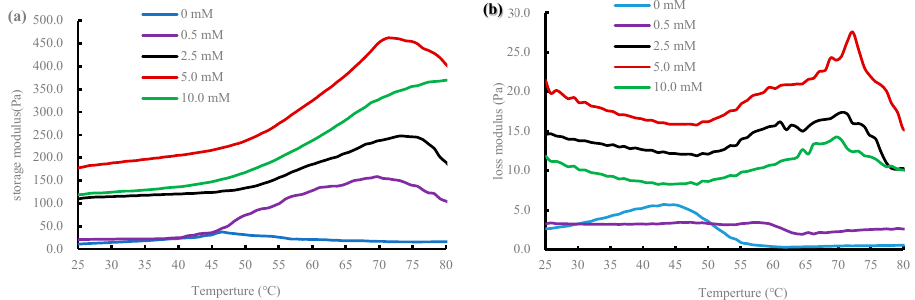
Figure 5. Storage modulus ( a ) and loss modulus ( b ) changes during heating of duck myofibrillar proteins treated with different malondialdehyde concentrations (0, 0.5, 2.5, 5.0, and 10.0 mmol/L).